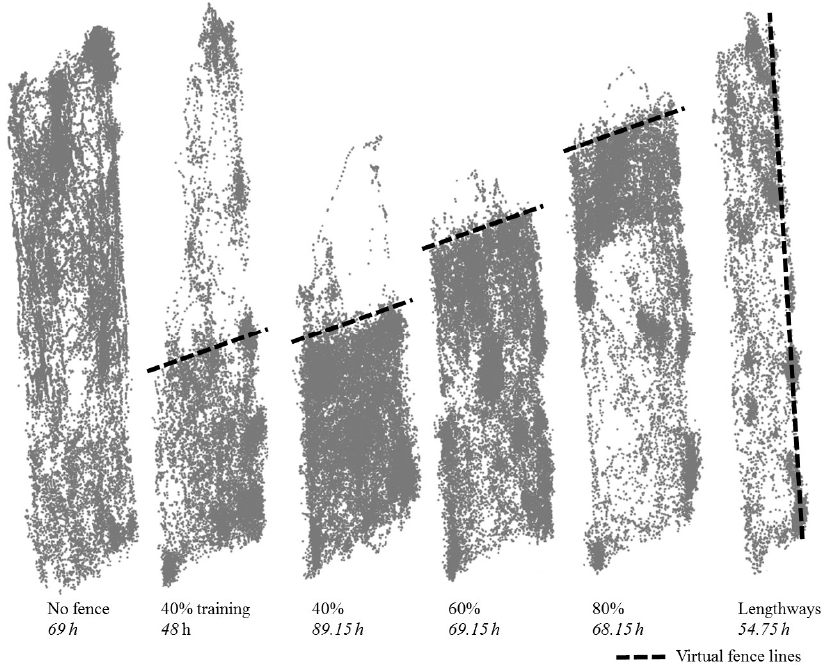
Figure 2. The global positioning system (GPS) positional data from all cattle ( n = 6) in the test paddock with the different virtual fence lines (dashed lines) set sequentially across a period of 22 days (total time within each fence period indicated in h). An approximately 48-h period within the 40% inclusion zone was separated out to display the learning period. Each point indicates a location a cow was present with some expected GPS error ± approximately 5 m. Due to collar malfunction, data were only recorded from n = 5 cows during the 80% fence period and from n = 4 cows during the lengthways period; collars were functional and kept the animals within the inclusion zones but did not log data.